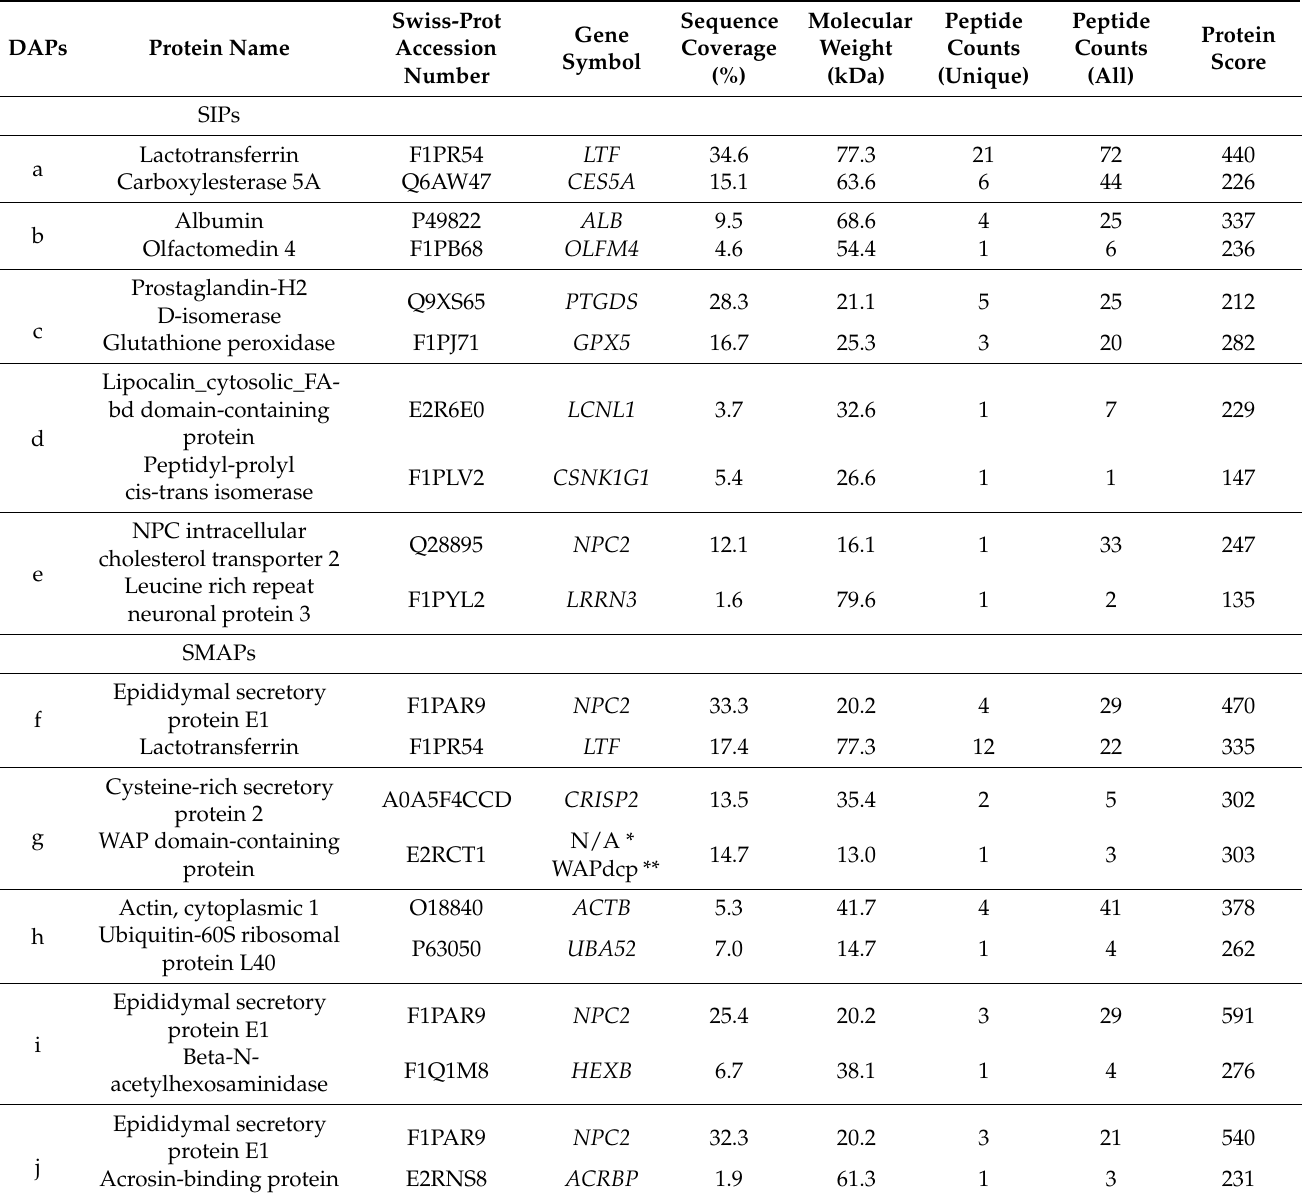
Table 2. Differentially abundant proteins (DAPs) of the SMAPs and SIPs present in dog ( Canis lupus familiaris ) cauda epididymal spermatozoa (n = 15). Proteins separated in SDS-PAGE were